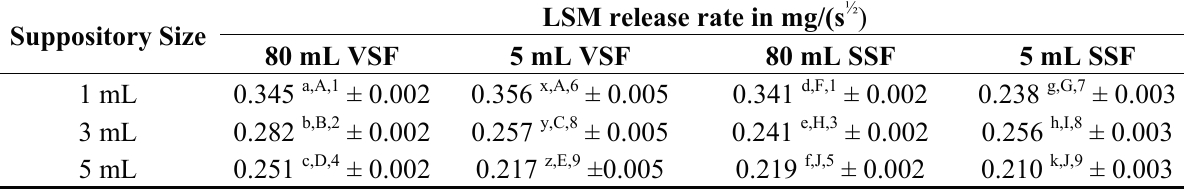
Table 1. Size influences the rate of TFV diffusion from semisoft carrageenan suppositories. Calculated in vitro release rates for TFV into VSF and SSF from the three different sizes of